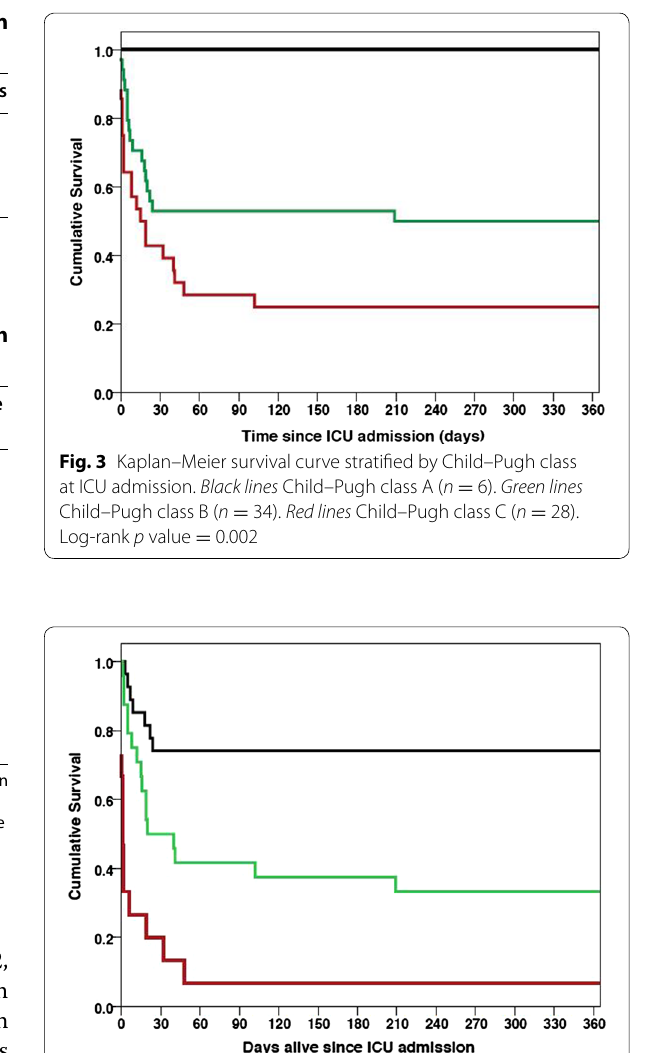
Lactate class + Lactate class 1 ( n 27). Green lines + = 24). Red lines ABC Lactate class 3 ( n = + = =